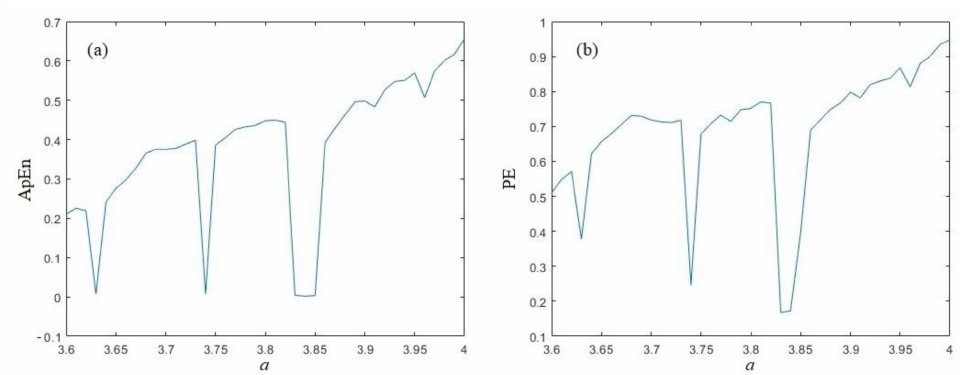
Figure 1. ( a ) ApEn analysis of the logistic sequence; ( b ) PE analysis of the logistic